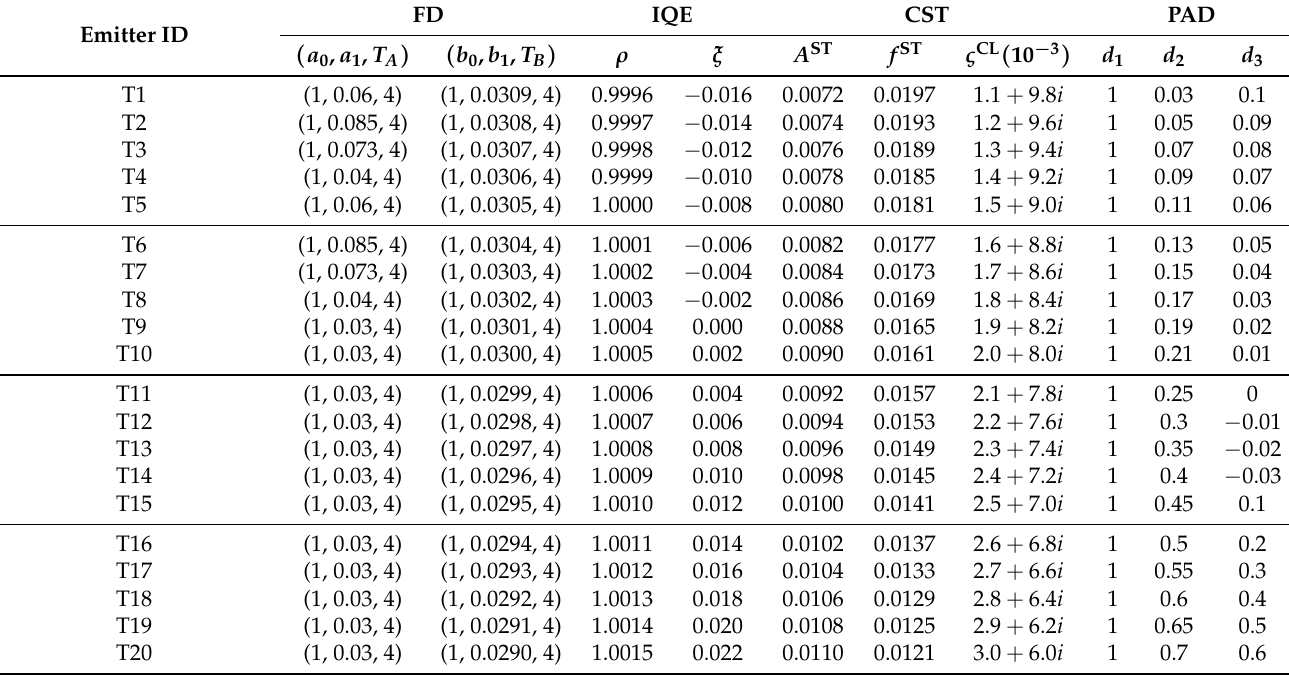
Table 2. Distortion parameters of simulated communication transmitters for Dataset 2.